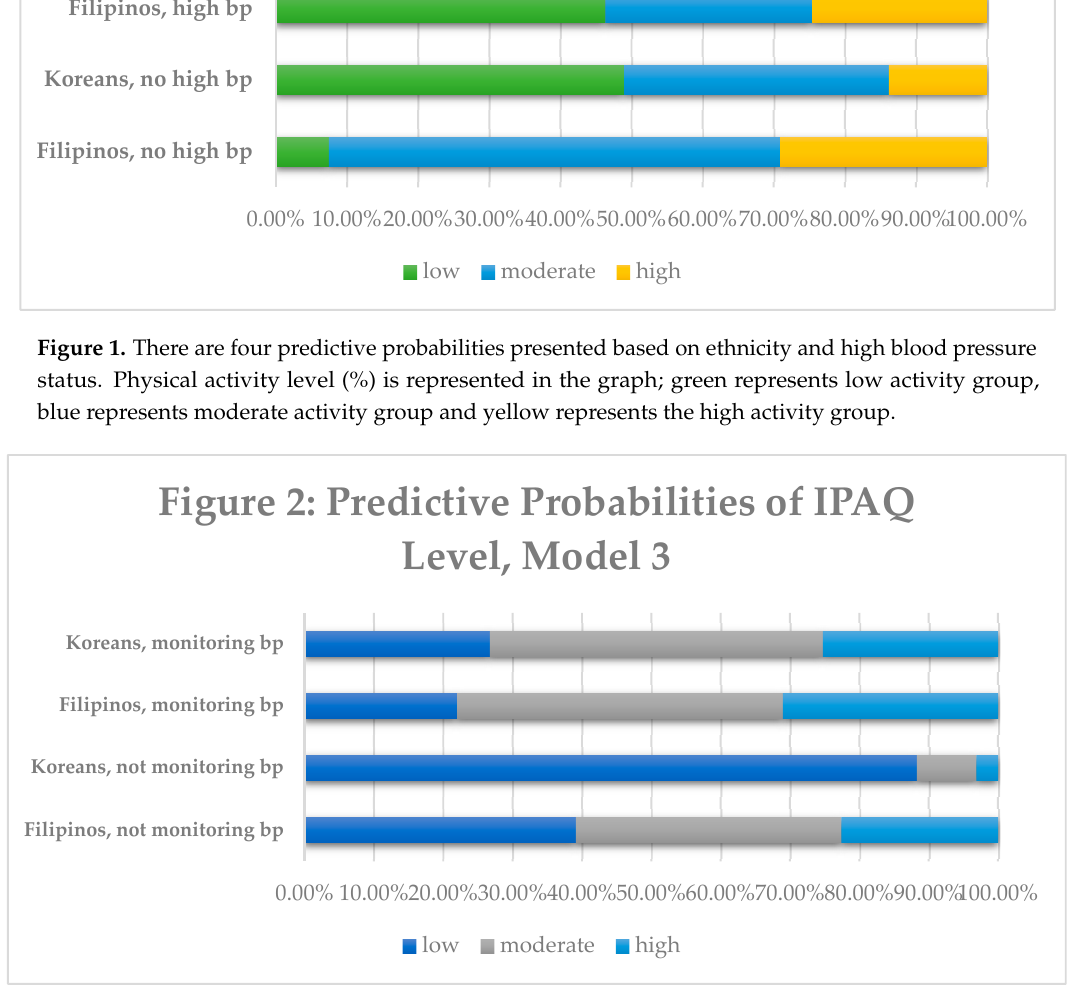
Figure 2. There are four predictive probabilities presented based on ethnicity and monitoring of blood pressure. Physical activity level (%) is represented in the graph; dark blue represents low activity group, grey represents moderate activity group and light blue represents the high activity group.